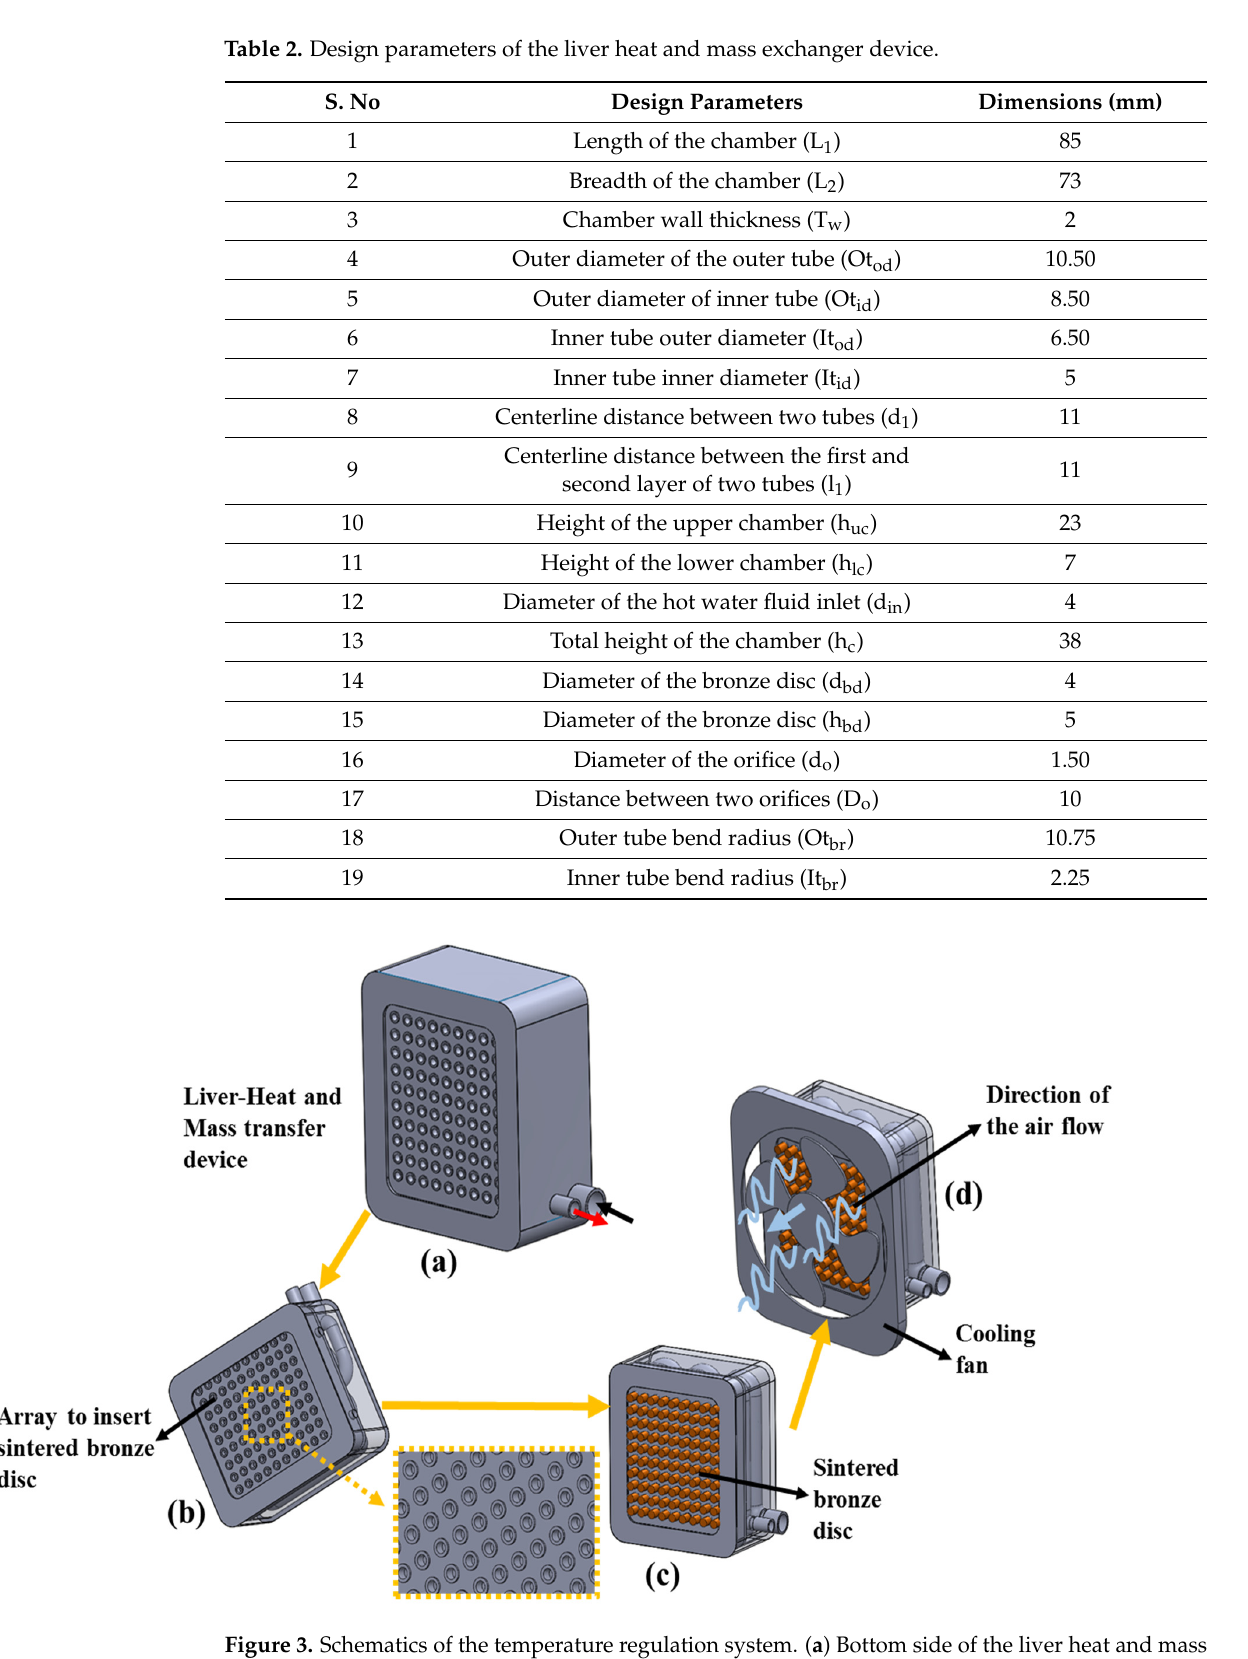
Figure 3. Schematics of the temperature regulation system. ( a ) Bottom side of the liver heat and mass transfer device, showing the lower chamber, ( b ) the lower chamber of the device, showing an array used to insert a sintered bronze disc, ( c ) the lower chamber of the device with the sintered bronze disc, and ( d ) the device attached to the cooling fan and showing the direction of the